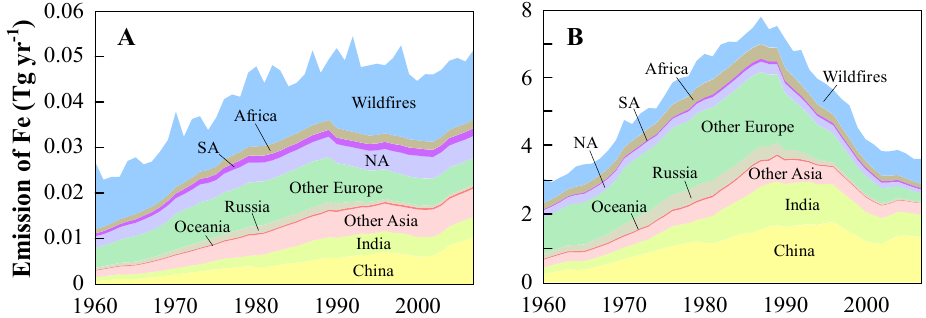
Figure 4 Figure 4. Temporal trends of Fe emissions of fine (PM 1 ) (a) and medium-to-coarse (PM 1 − 10 and PM > 10 ) (b ) particles from combustion sources from 1960 to 2007. Fe emissions from wildfires are shown separately with energy-related activities separated by region (NA for North America and SA for South America).